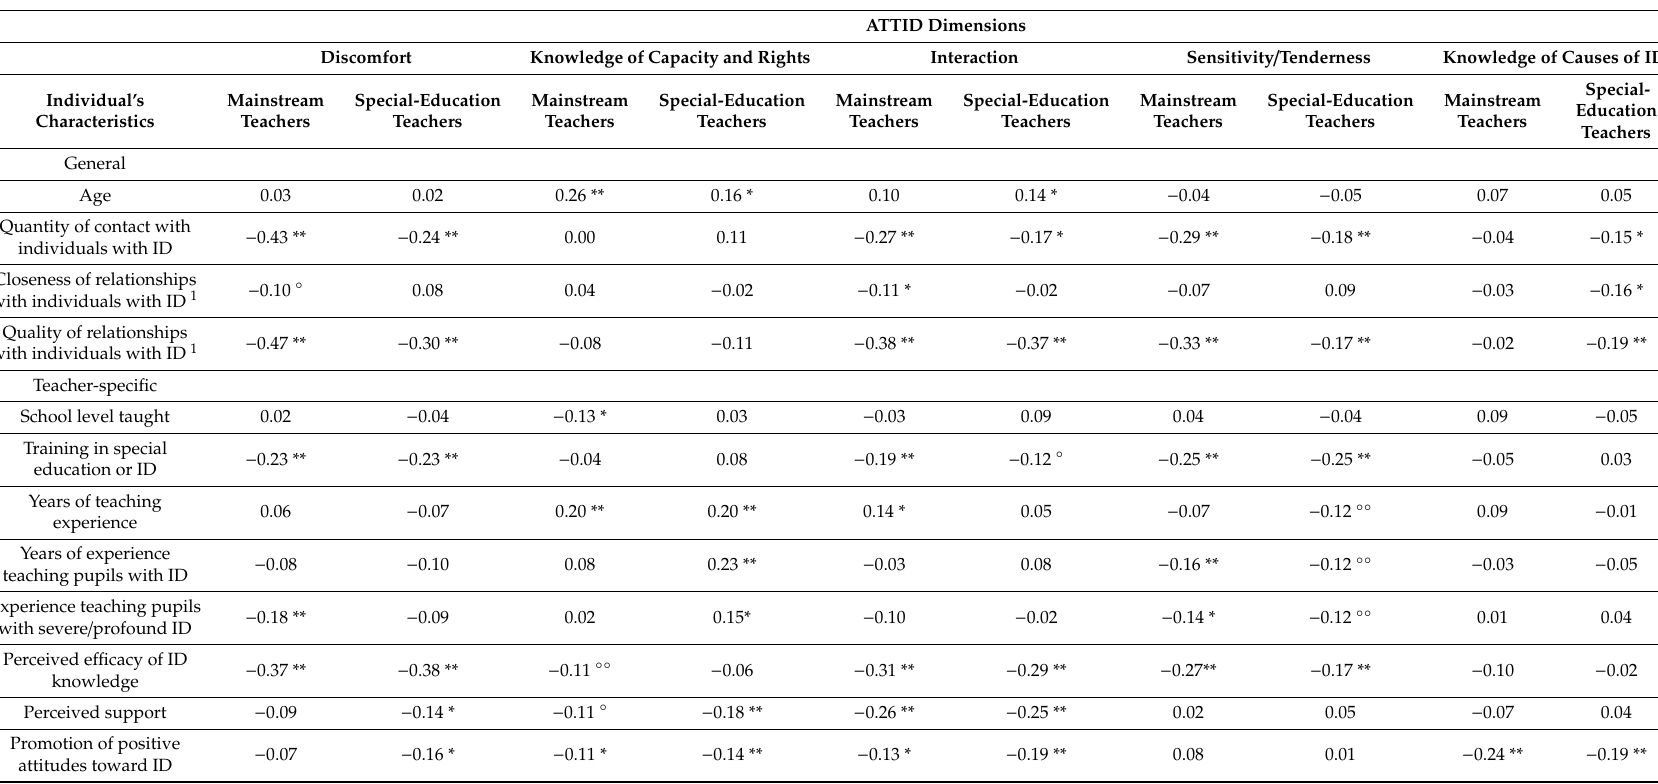
Table 3. Correlation coe ffi cients between general and teacher-specific characteristics and each dimension of the ATTID questionnaire for mainstream teachers and special-education teachers. ATTID Dimensions Discomfort